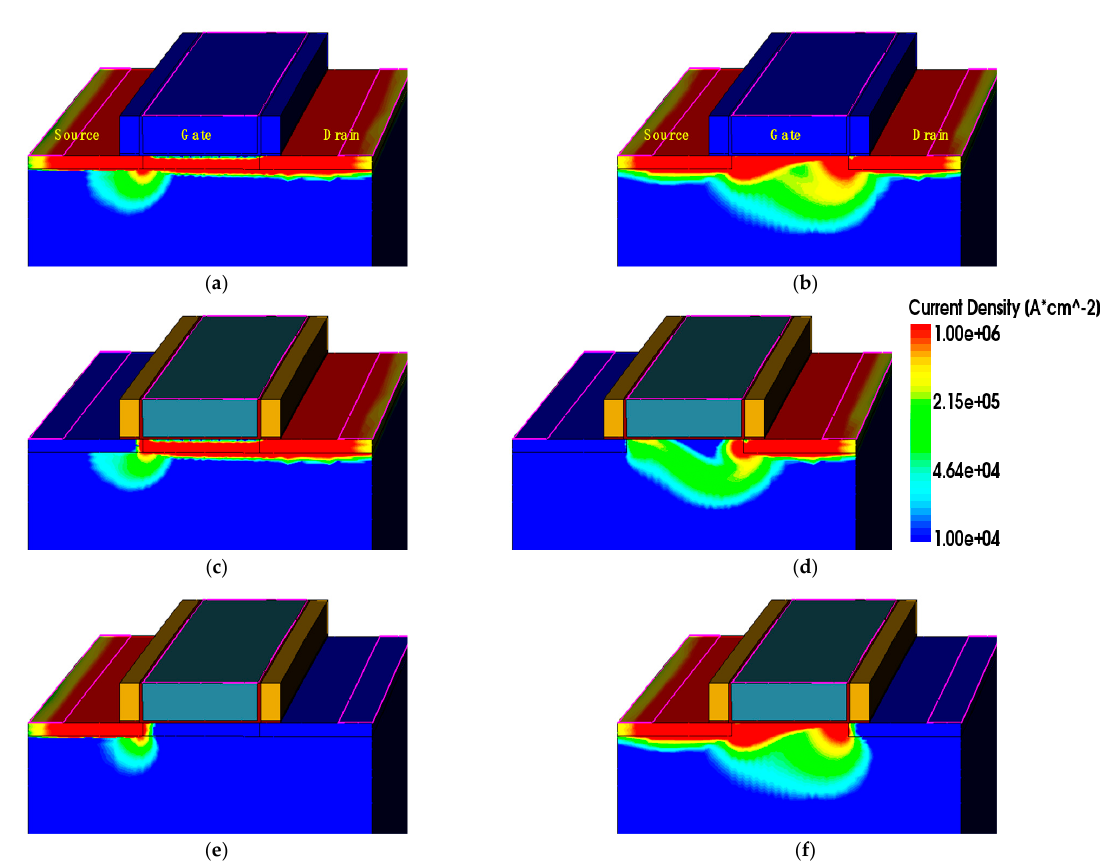
Figure 6. Contour plots of ( a ) total current density, ( b ) hole current density and ( c ) electron current density of PNN TFET and ( d ) total current density, ( e ) hole current density, and ( f ) electron current density of Conventional TFET at 90 ns under 1 mA/ μ m TLP current. For clarity, only part of the device is shown.